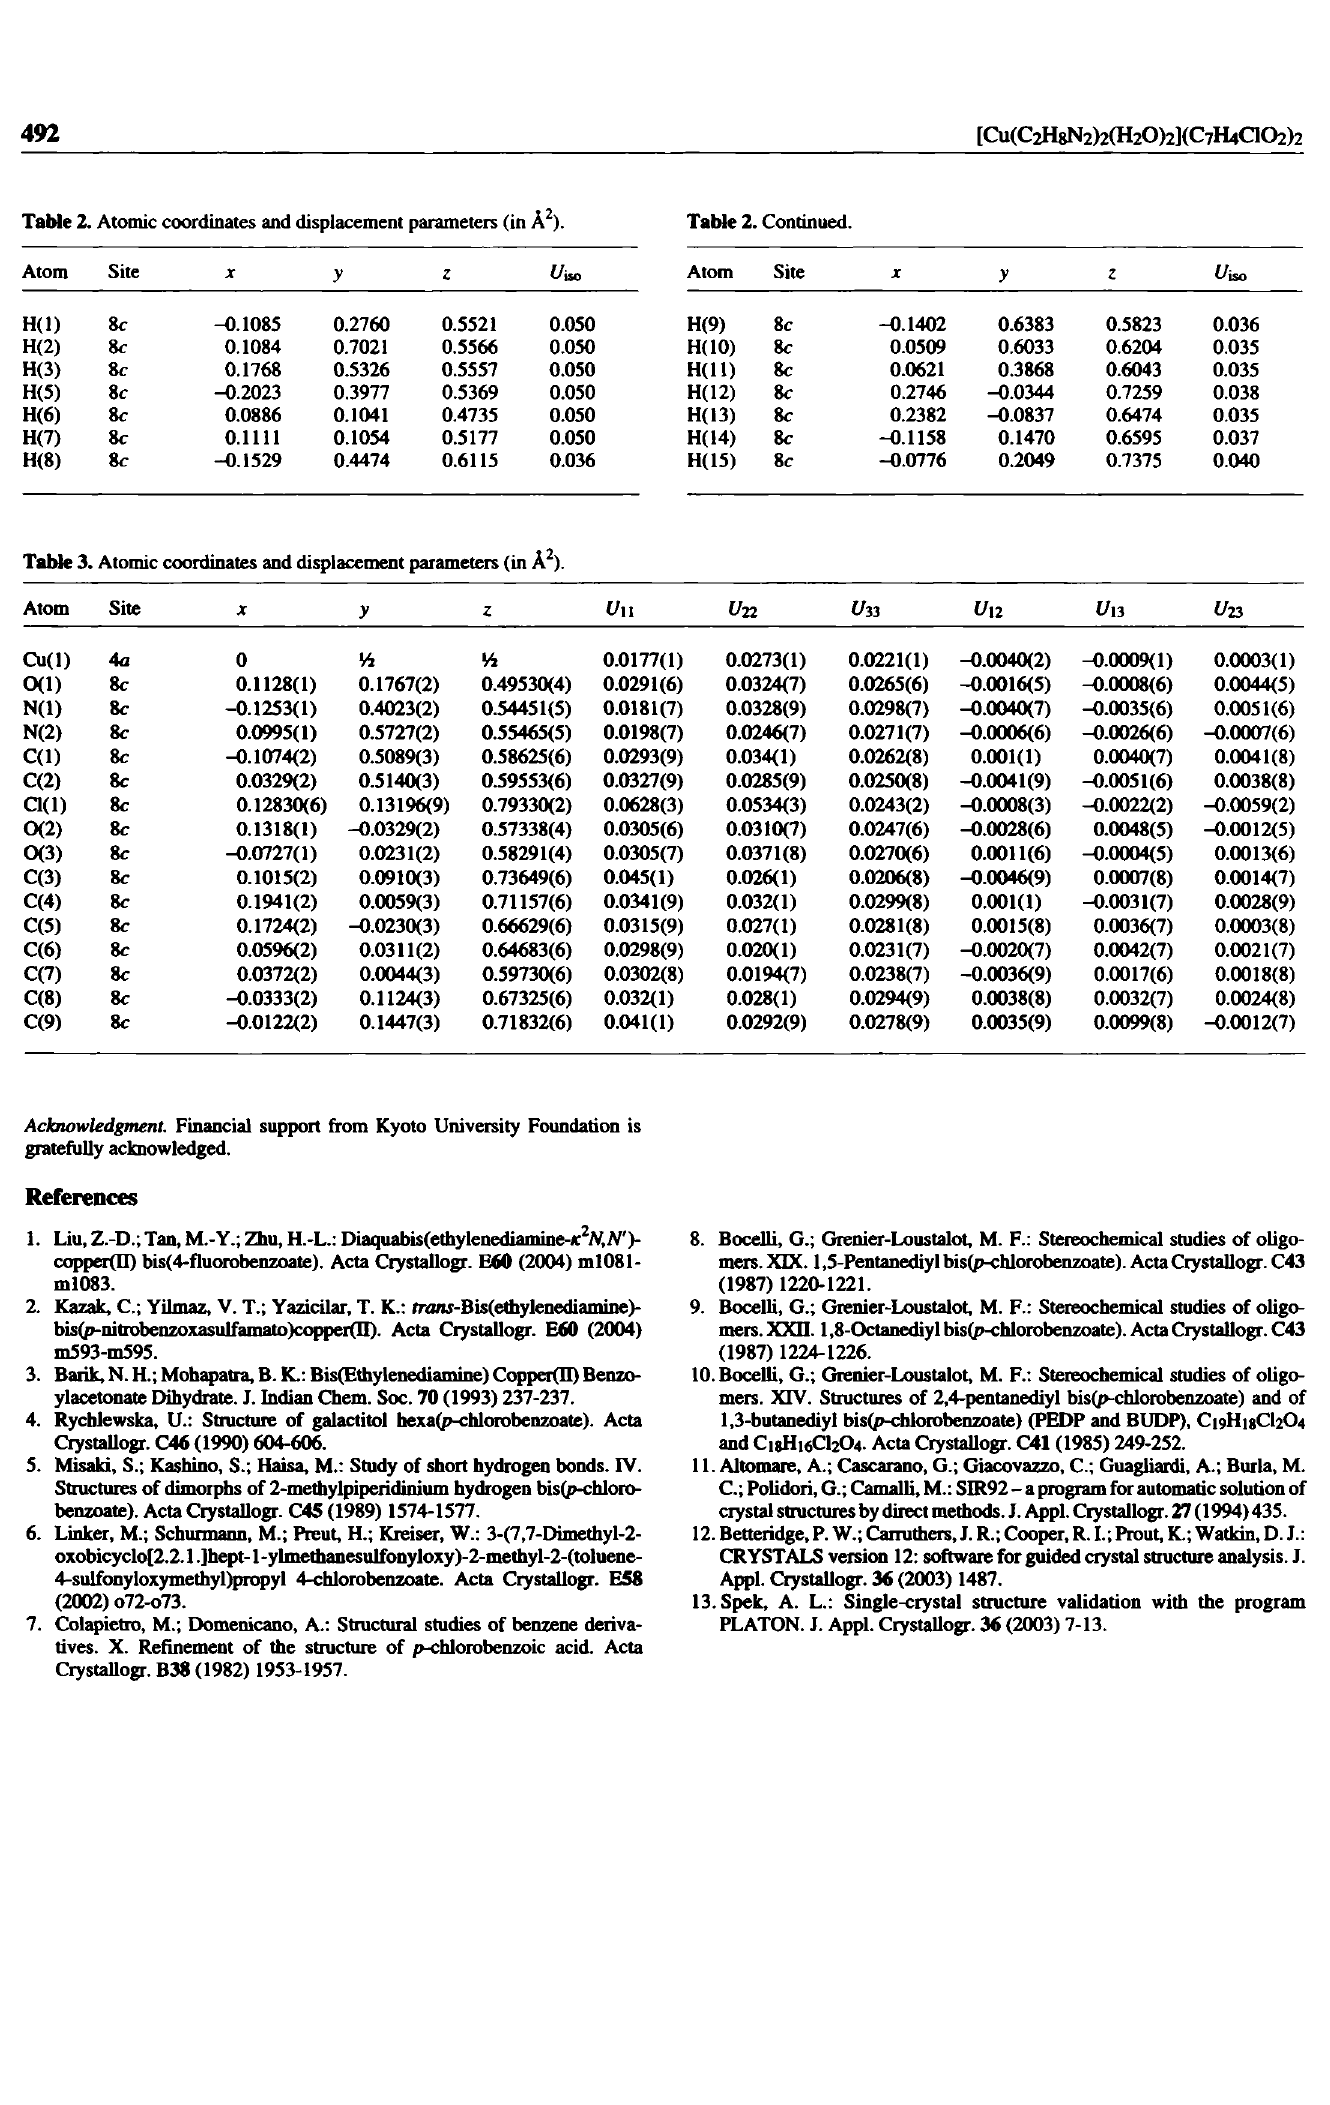
Table 3. Atomic coordinates and displacement parameters (in A 2